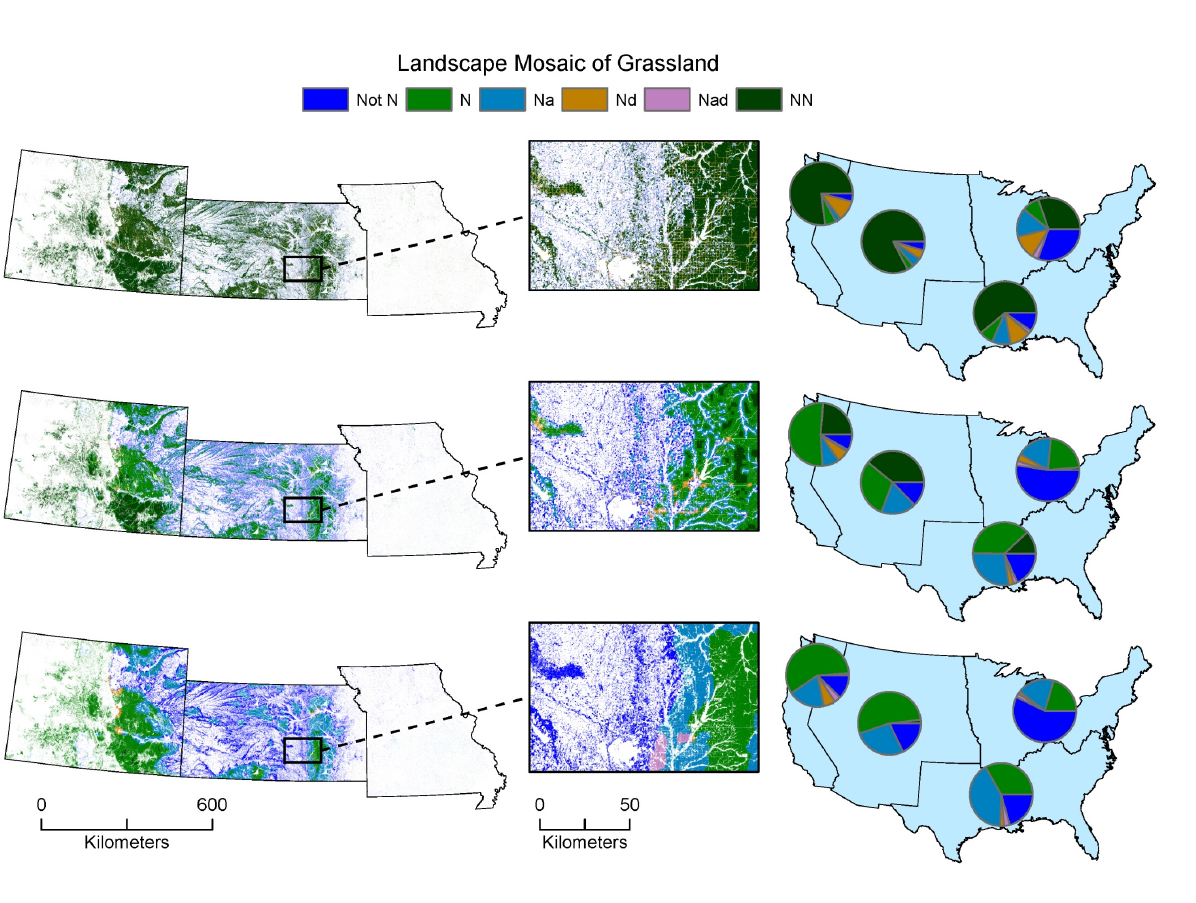
Figure 3: The landscape mosaic of grassland, in landscapes that are dominated by natural land-cover. Left: Grassland distribution is indicated by the colored pixels, and the color of a pixel indicates its landscape mosaic context in landscapes of size 4.4 ha (top), 591 ha (middle), and 47800 ha (bottom). Center: Illustrations of spatial detail near the city of Wichita. Right: The relative proportions of grassland area in anthropogenic interface zones in each of four regions are shown by the pie charts. Note: „Not N“ refers to landscape backgrounds not dominated by natural land-cover